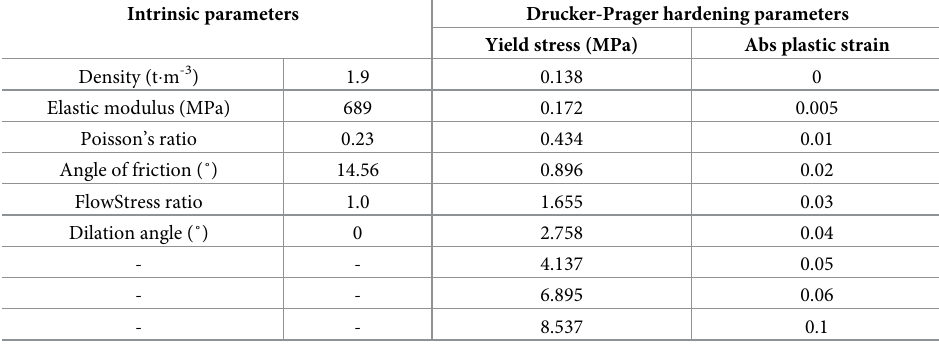
Table 3. Material parameters of quartz sand. Intrinsic parameters and Drucker- Prager hardening